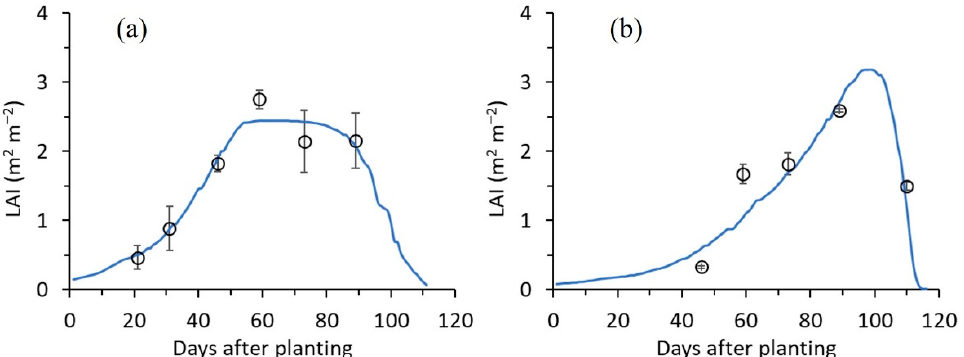
Figure 7. Simulated (Sim) versus observed (Obs) leaf area index (LAI) values of barley at the Gyeongsang National University field: ( a ) autumn-sown with nitrogen (N) treatments of 40% (32 kg ha − 1 ) at seeding, 30% (24 kg ha − 1 ) at rejuvenation, and 30% (24 kg ha − 1 ) at early reproduction (N40-30-30) and ( b ) spring-sown N40-30-30. Table 4. Observed versus simulated wheat grain yields for the different treatments in terms of the p -value shown by the t-test, the mean absolute error (MAE), the root mean squared deviation (RMSD), and normalised Nash–Sutcliffe model efficiency (NME).